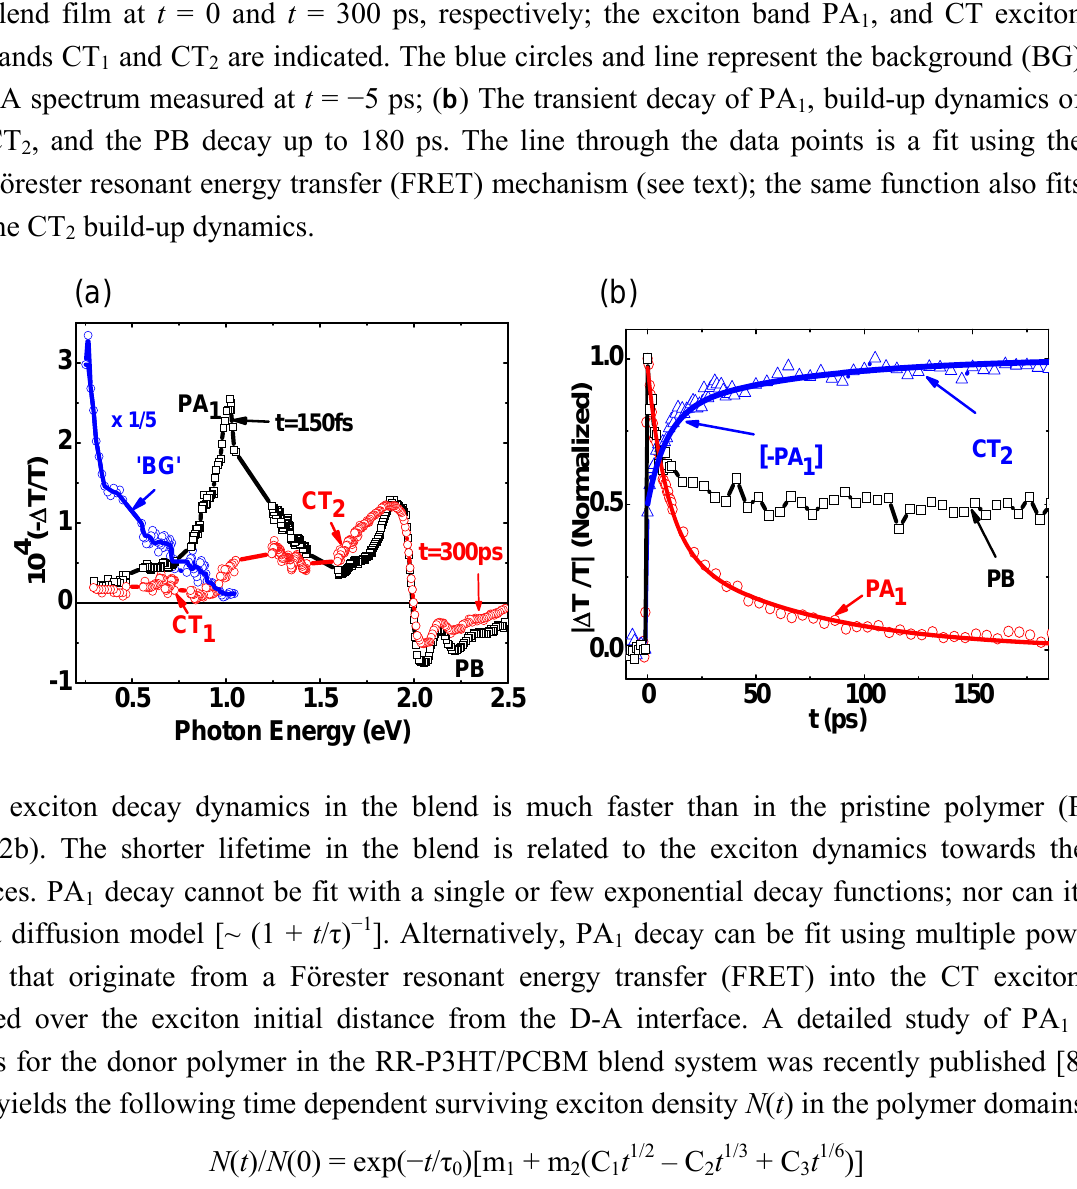
, and CT exciton 1 , build-up dynamics of 1